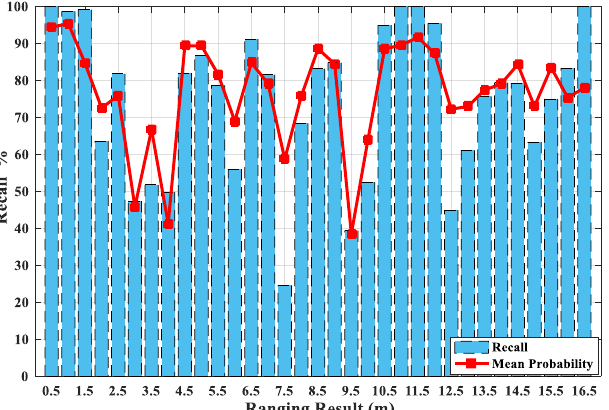
Figure 11. Cumulative distribution function of the precisions.